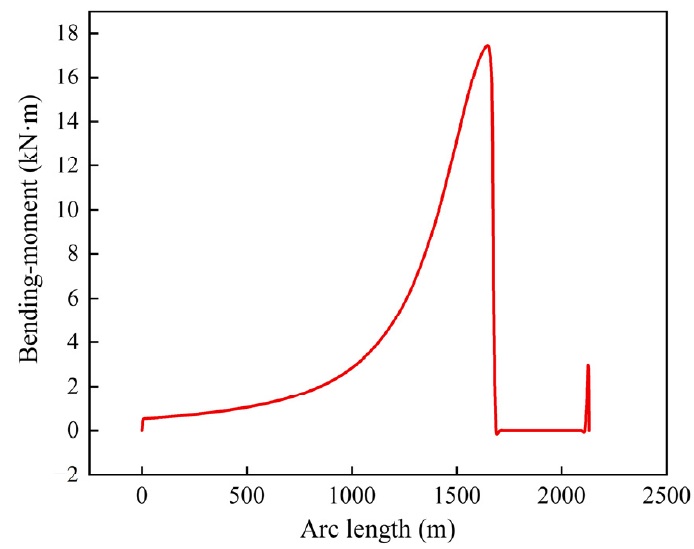
Figure 15. Static configuration of in situ SCR.